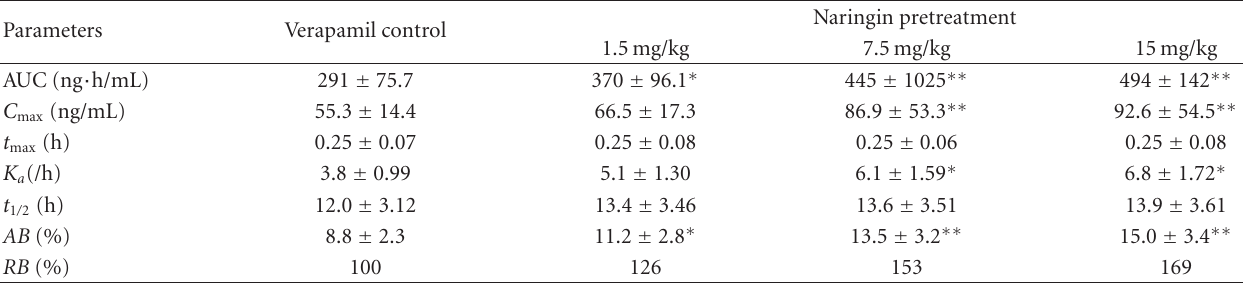
Table 33: Pharmacokinetic parameters of verapamil (9mg/kg) and in combination with naringin pretreated rabbits after oral administration [222].